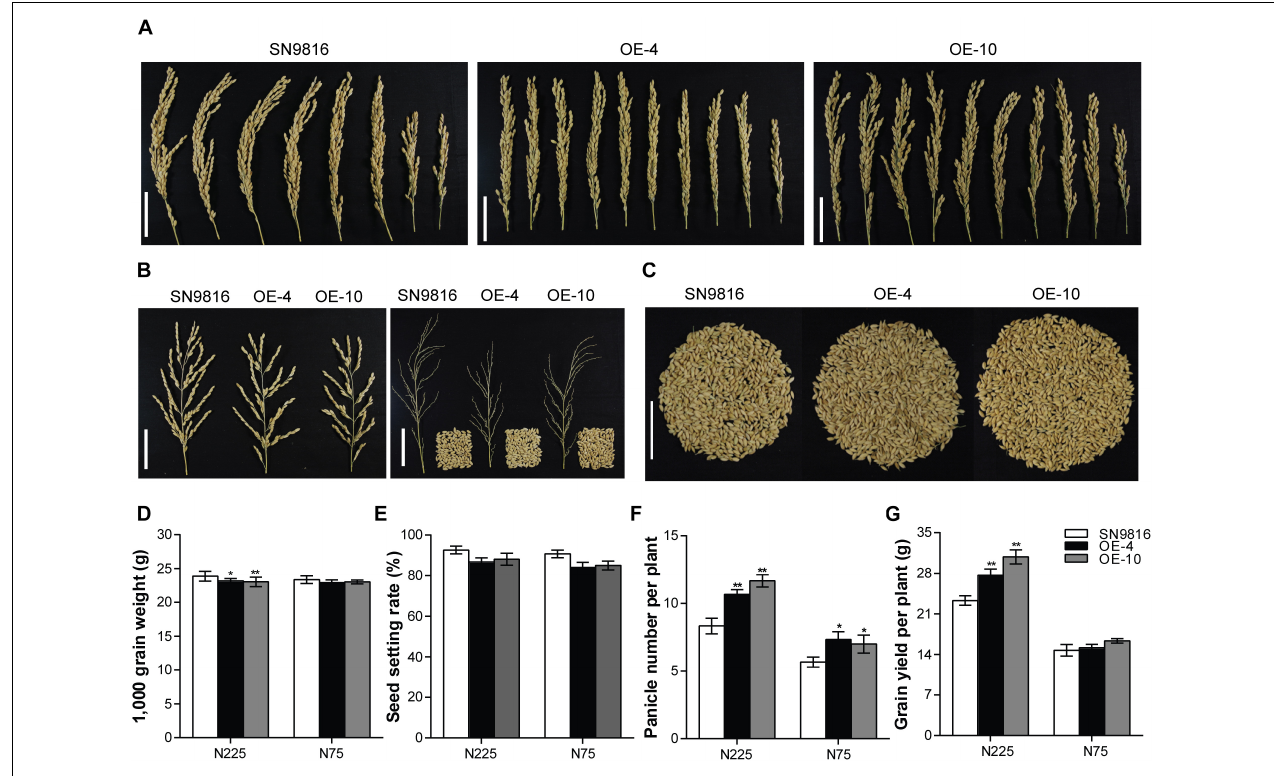
FIGURE 3 | Comparison of yield-related characteristics between SN9816 and 35S-OsATG8a transgenic rice. Phenotypes of (A) panicle number per plant, (B) panicle and grain number per panicle, and (C) grain number per plant in SN9816 and transgenic lines (OE-4 and OE-10) under N225 condition. Scale bars, 5 cm. (D) Thousand grain weight, (E) seed setting rate, (F) panicle number per plant, and (G) grain number per plant of SN9816 and transgenic lines (OE-4 and OE-10) under N225 or N75 conditions. Values are means ± SD of one representative biological replicate ( n = 12) out of three, ∗ P < 0.05, ∗∗ P < 0.01 ( t